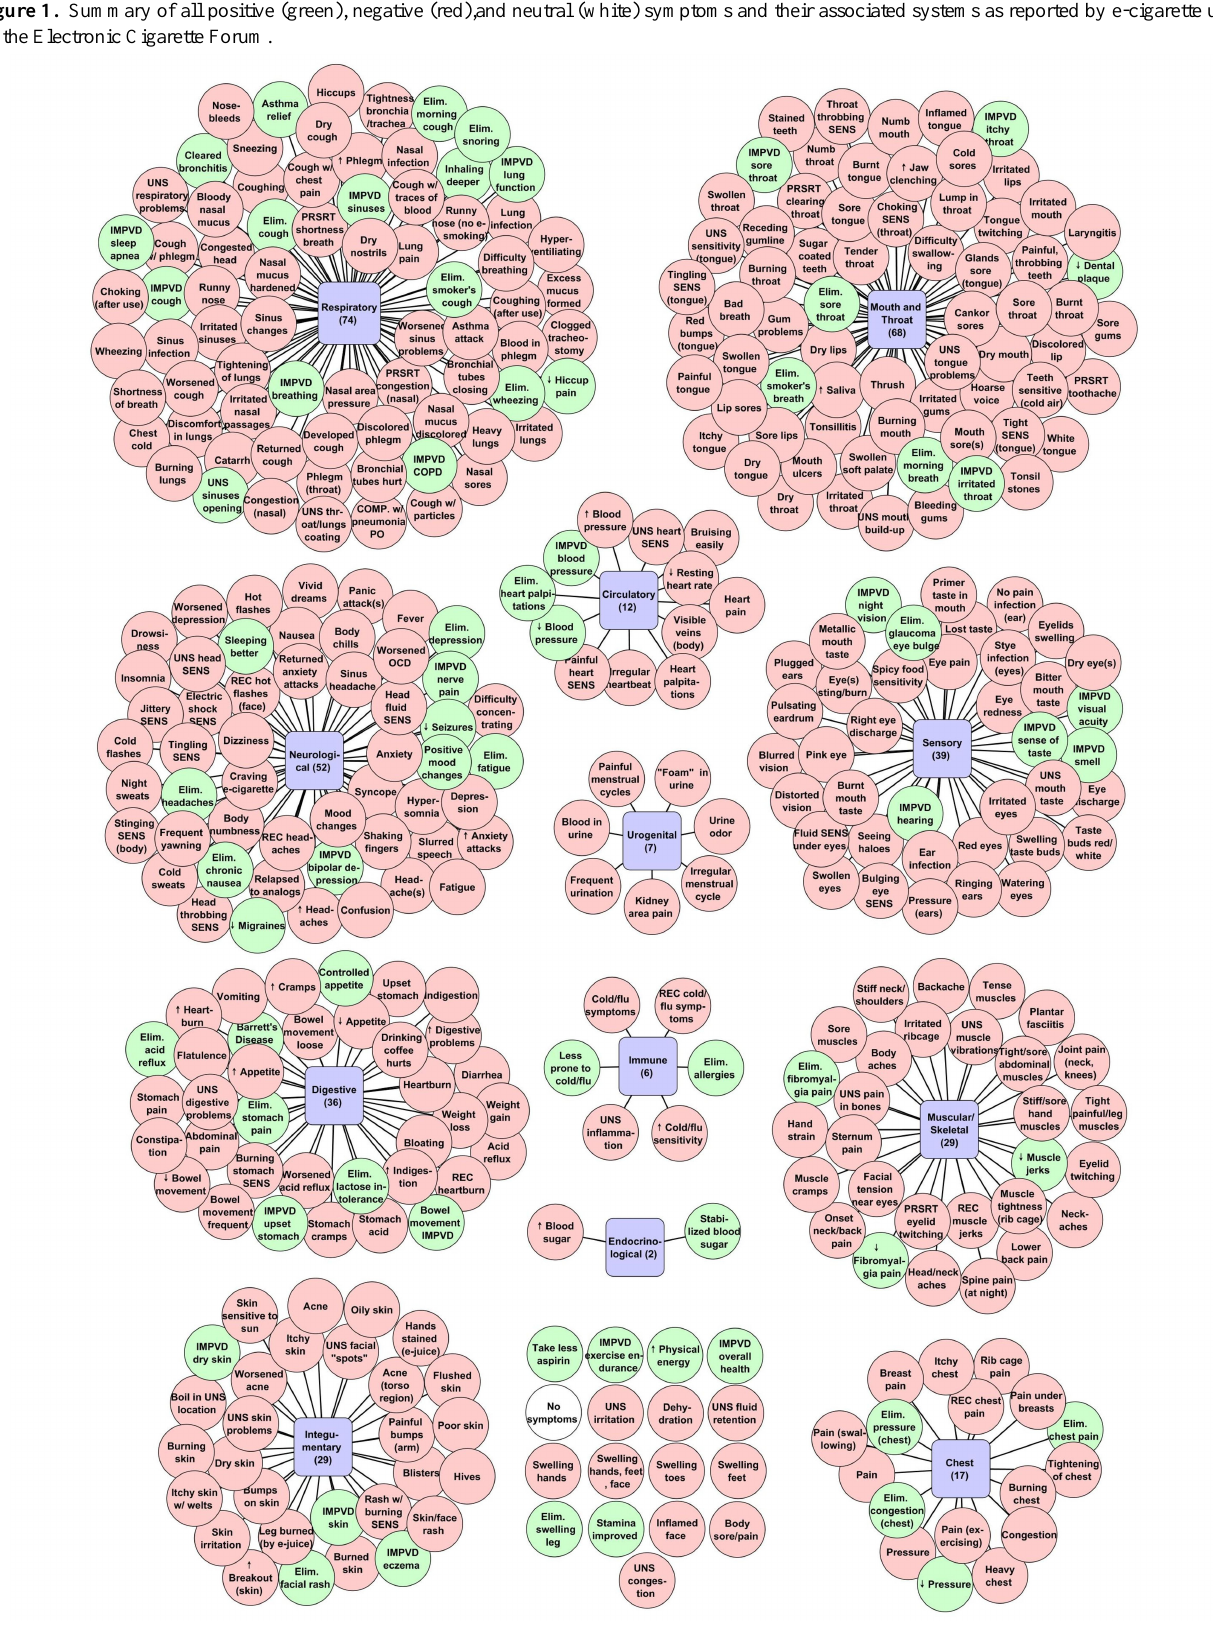
Figure 1. Summary of all positive (green), negative (red),and neutral (white) symptoms and their associated systems as reported by e-cigarette users on the Electronic Cigarette